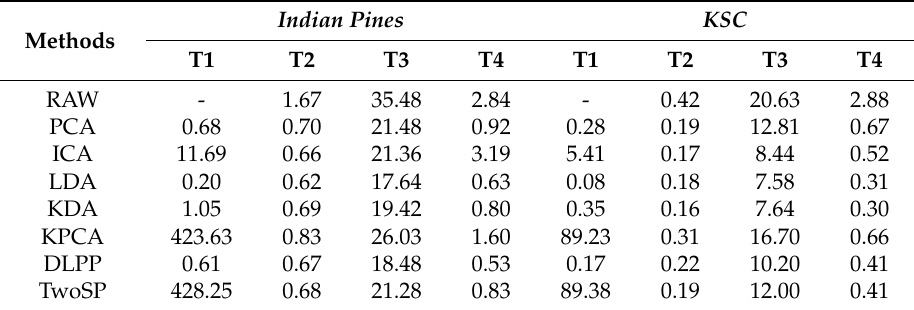
Table 5. Computational time ( s ) of different methods on Indian Pines and KSC datasets.